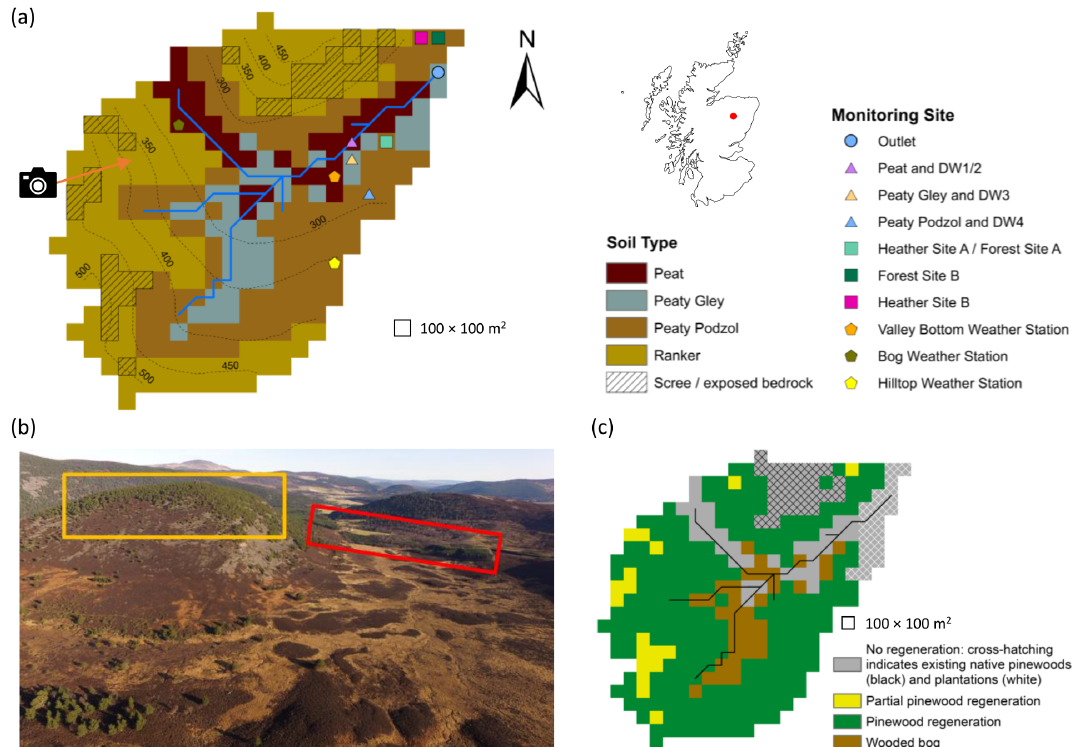
Figure 1. Characteristics of the Bruntland Burn catchment. (a) Map showing the distribution of soil types, monitoring sites (DW is deeper groundwater well) and elevation contours. (b) Aerial view showing the current distribution of vegetation types in the catchment; yellow and red boxes show areas of established natural forest and land managed for plantations, respectively, while the direction of the photo is shown by the arrow in panel (a) . (c) Map of regeneration potential (partial pinewood regeneration signifies areas where regeneration was limited to due to presence of scree/exposed bedrock). Photograph in panel (b) by Aaron J.